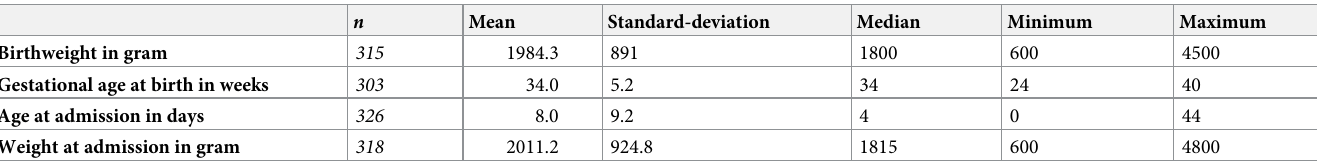
Table 2. Demographical